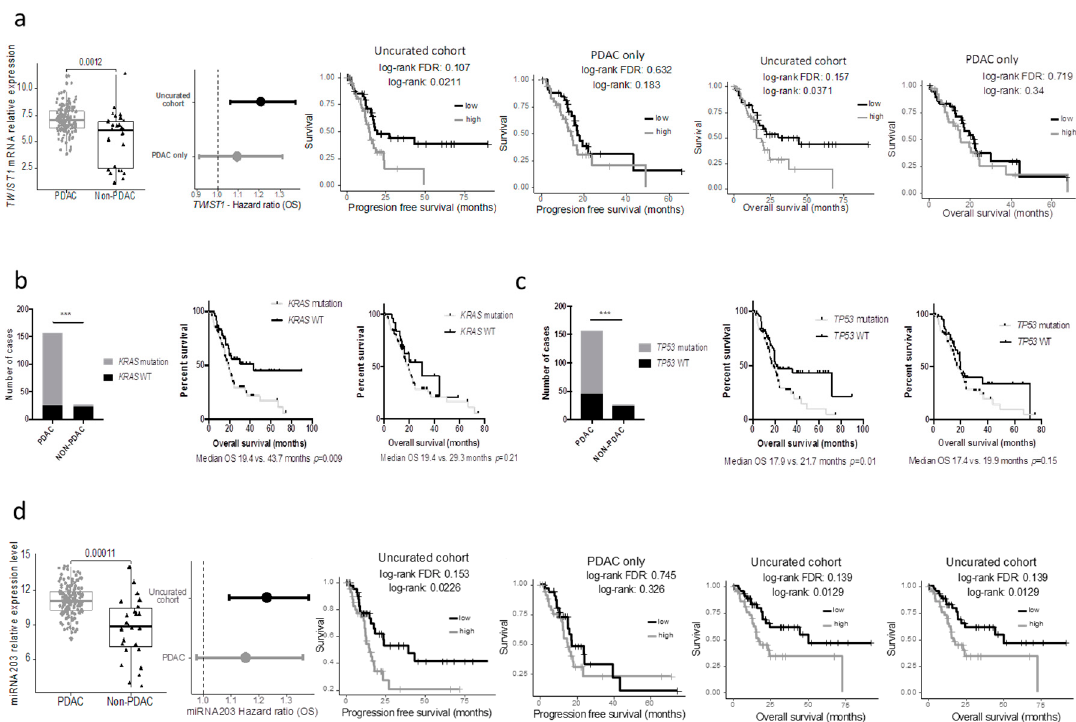
Figure 4. Bias in prognostic analysis when using the uncurated cohort. ( a ) TWIST1 mRNA expression in PDAC and non-PDAC cases and prognostic impact (OS) in the uncurated and the PDAC only cohorts (left panels). Kaplan-Meier curves depicting the overall (middle panel) and progression-free survival (right panels) according to TWIST1 expression in the uncurated cohort or the PDAC only cohort. ( b ) and ( c ) Distribution of the KRAS and TP53 mutation in the PDAC and non-PDAC cases (left panels) and Kaplan-Meier curves depicting the overall survival according to the mutational status in the uncurated cohort (middle panels) or the PDAC-only cohort (right panels). ( d ) miR-203 mRNA expression in PDAC and non-PDAC cases and prognostic impact (OS) in the uncurated and the PDAC only cohorts (left panels). Kaplan-Meier curves depicting the overall (middle panel) and progression-free survival (right panels) according to miR-203 expression in the uncurated cohort or the PDAC only cohort.